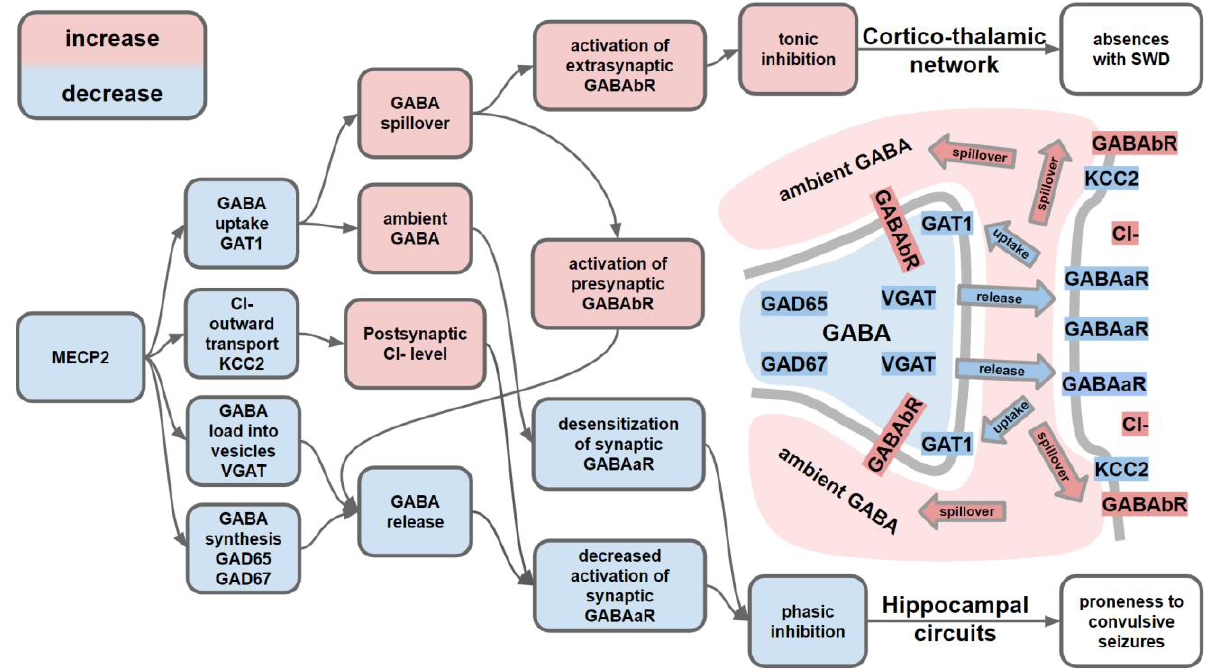
Figure 1. Role of GABAergic impairment in pathogenesis of epileptic activity in the animal model of RTT.